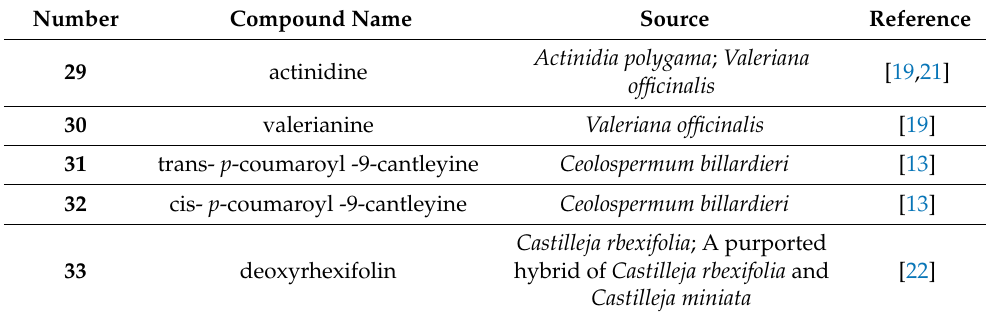
Table 2. Pyridine alkaloids derived from iridoids (Type II).